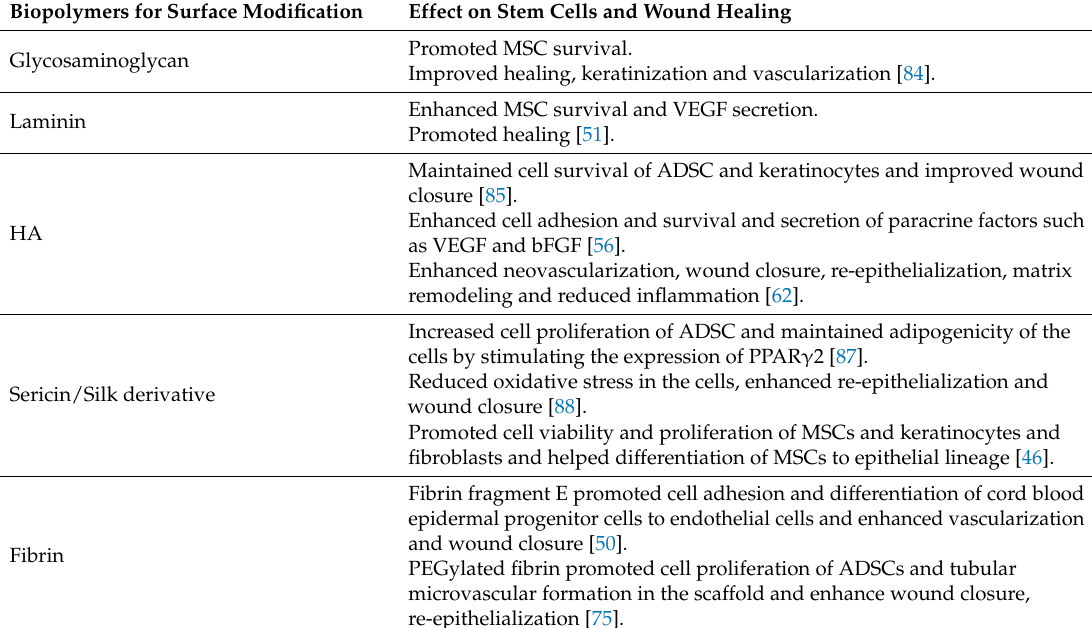
Table 3. Surface modifications of scaffolds for wound healing